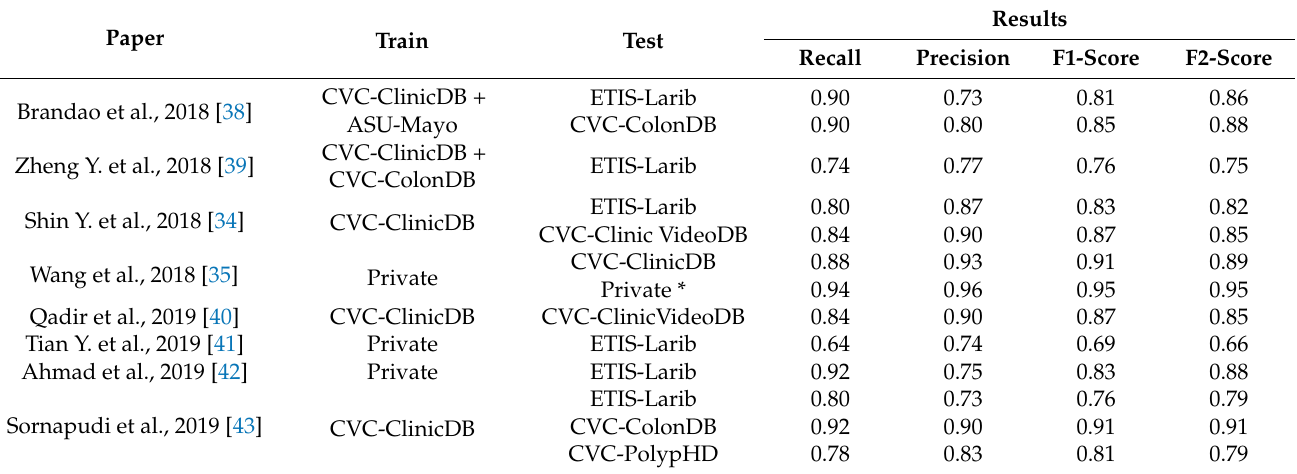
Table 2. Performance results of studies evaluating DL models for polyp localization in at least one of the selected public colonoscopy image